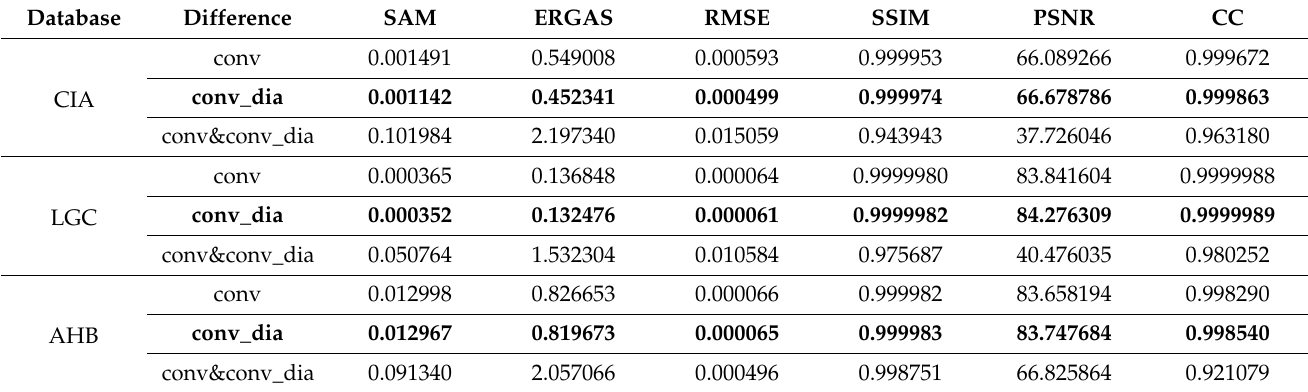
Table 6. Average evaluation values of various convolution operations on the three